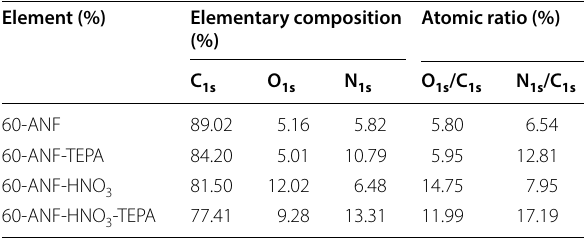
XPS-derived elemental compositions and atomic ratios of 60-ANF-based